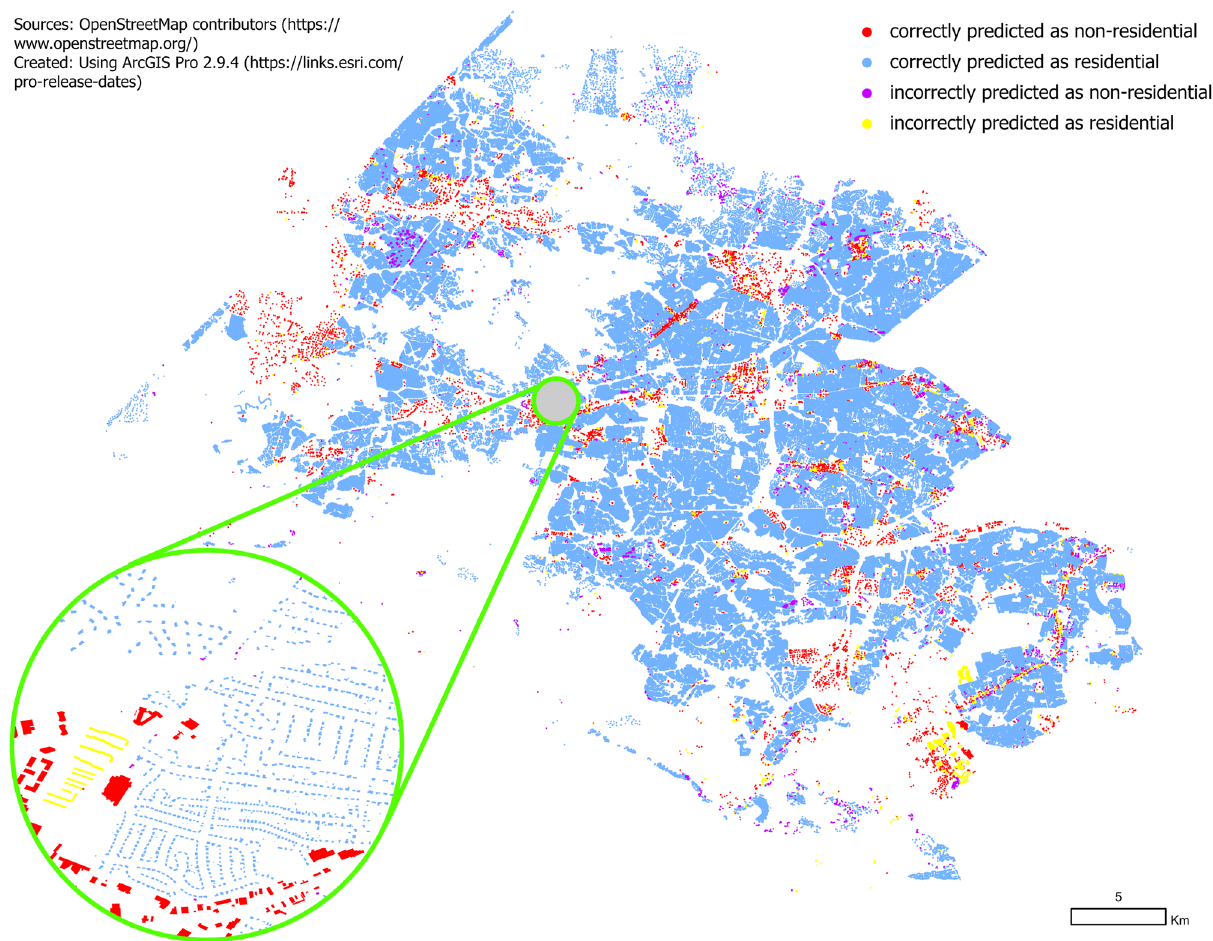
Figure 2. Residential and non-residential building type based on our proposed model for Fairfax County,